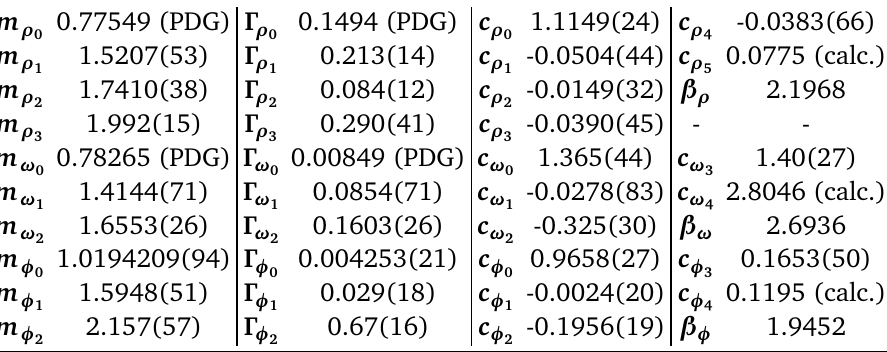
Table 5: Parameters for the description of K K production from our fit using the model of Ref. [ 69 ] . All masses and widths are given in GeV, all other parameters are dimensionless